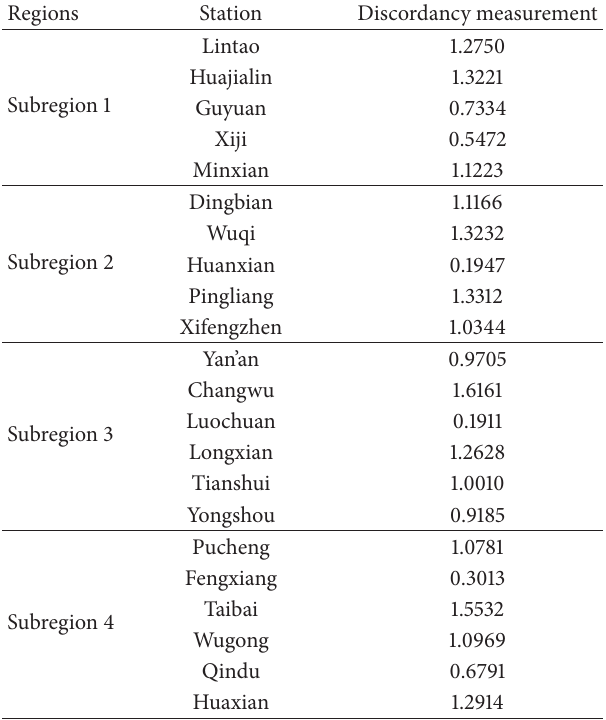
Table 3: Values of the discordancy measure of the four subregions in the WRB.